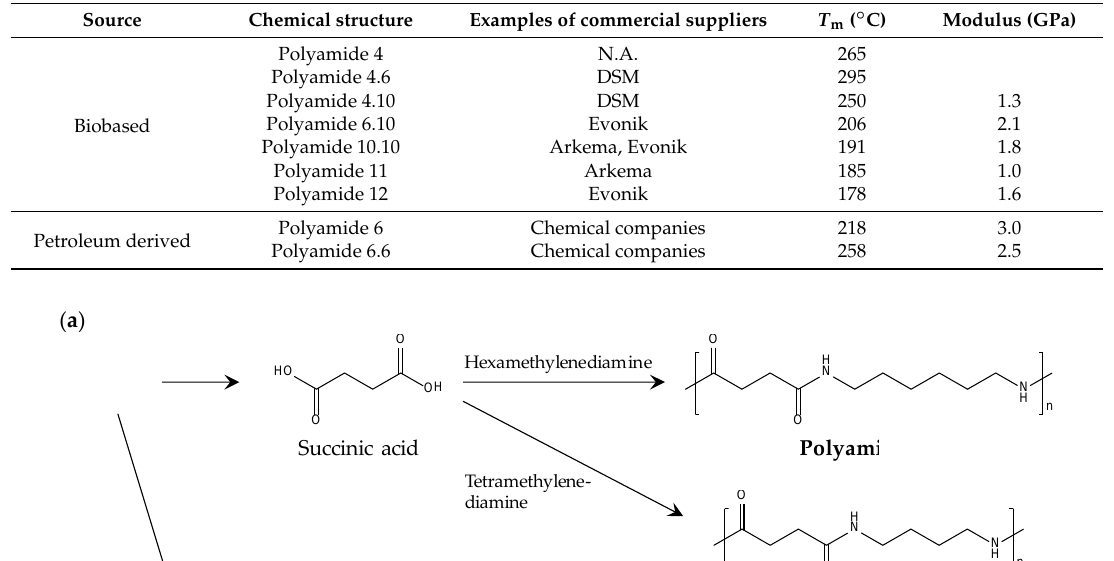
Table 6. Chemical structures, suppliers, T m , and moduli of biobased polyamides [77–79].